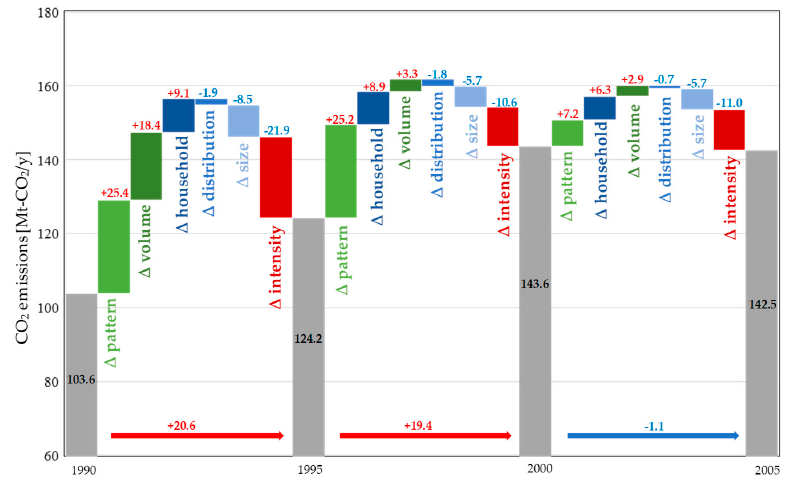
Figure 3. Driving forces of direct household CO 2 emissions in Japan during 1990-2005. ∆ intensity is the intensity effect, ∆ pattern is the consumption pattern effect, ∆ volume is the consumption volume effect, ∆ size is the household size effect, ∆ distribution is the household distribution effect, and ∆ household is the household number effect.